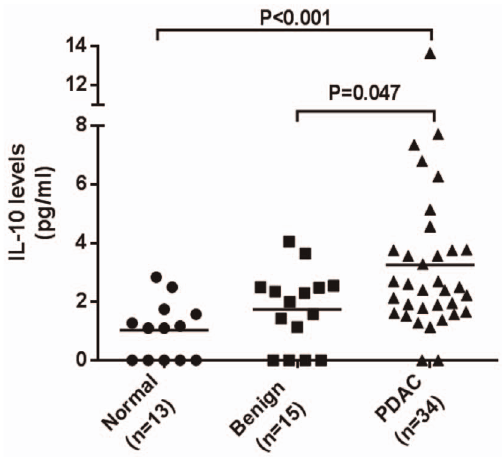
Figure 2. Plasma IL-10 concentration. This figure displays the plasma IL-10 levels observed in the different disease groups: pancreatic cancer patients (n=34), patients with benign pancreatic disease (n=15), or healthy controls (n = 13). Median values of each group are presented by the horizontal lines. The plasma IL-10 levels was elevated in pancreatic cancer patients, with a median at 2.45 pg/mL (n=34), which was significantly higher than both healthy donors (P , 0.001), whose median was 1.10 pg/mL (n=13), and benign pancreatic disease patients (P=0.047), with median plasma IL-10 concentration at 1.99 pg/mL, (n=15). There is no significant difference between normal volunteers and patients with benign pancreatic disease in the regards of plasma IL-10 levels (P=0.14).